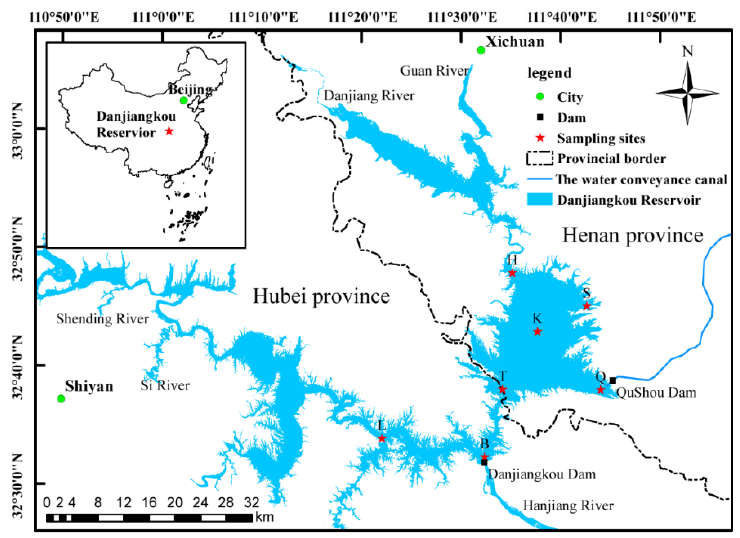
Figure 1. Sketch map of the 7 sampling sites in the Danjiangkou Reservoir.